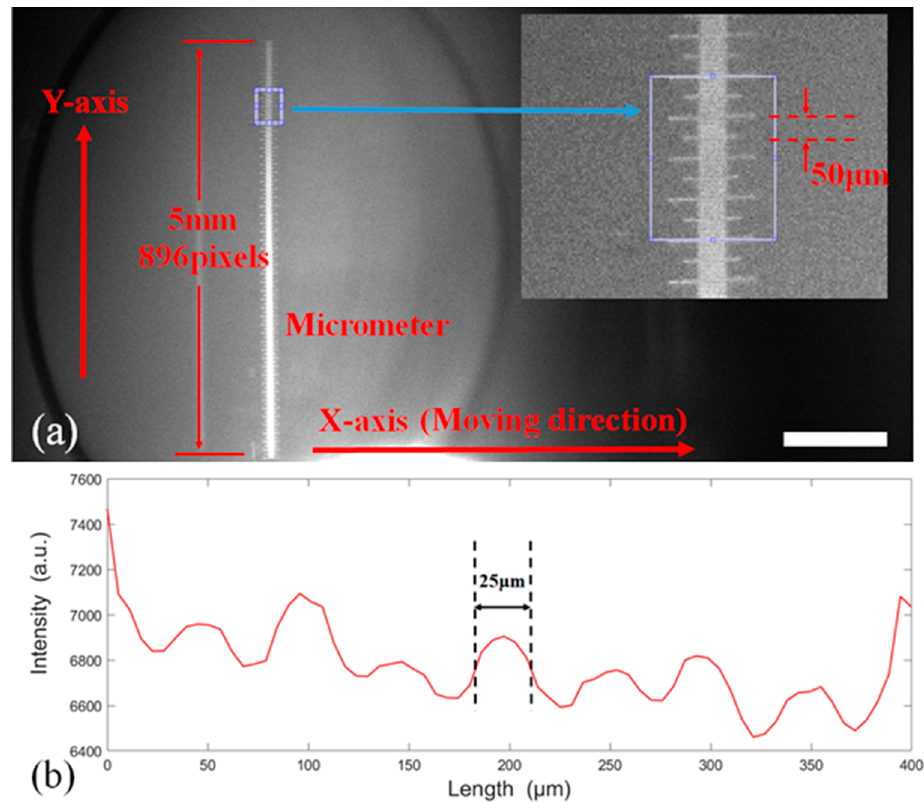
Figure 5. ( a ) Micrometer ruler used to determine the system resolution in the y-direction. Insert shows a magnification of the section used in the measurement. Scale bar: 1 mm. ( b ) Calculated line profile of the optical intensity.